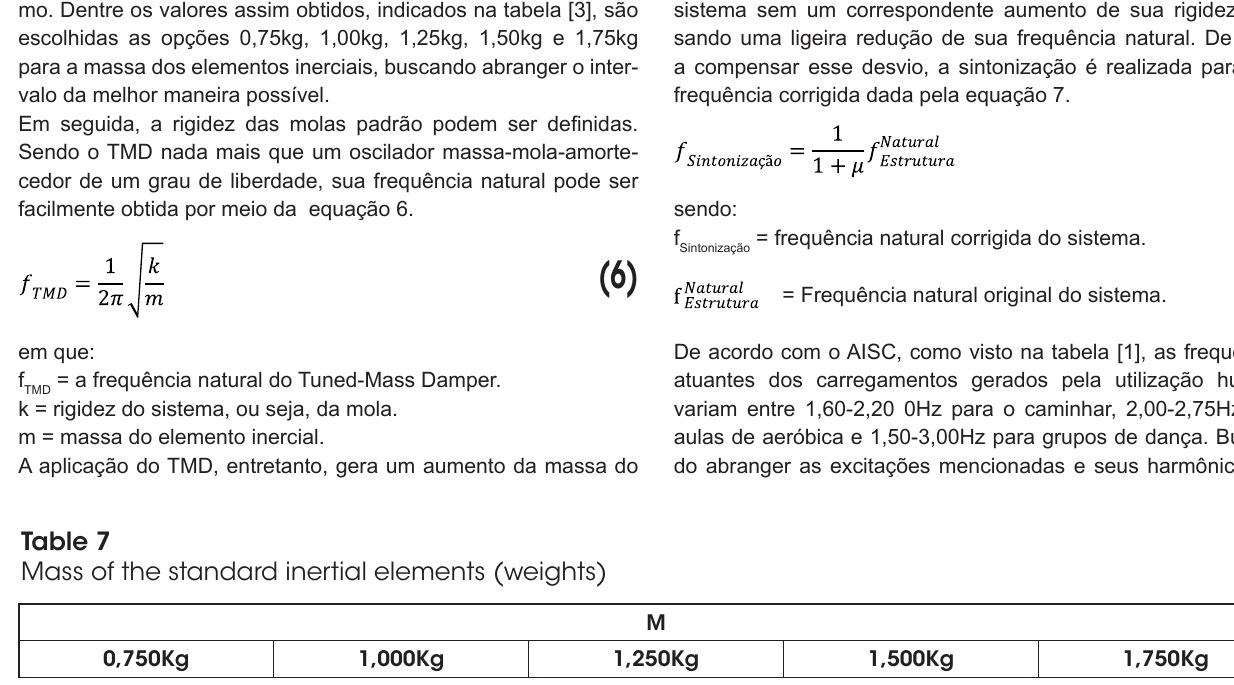
mo. Dentre os valores assim obtidos, indicados na tabela [3], são escolhidas as opções 0,75kg, 1,00kg, 1,25kg, 1,50kg e 1,75kg para a massa dos elementos inerciais, buscando abranger o inter- valo da melhor maneira possível.